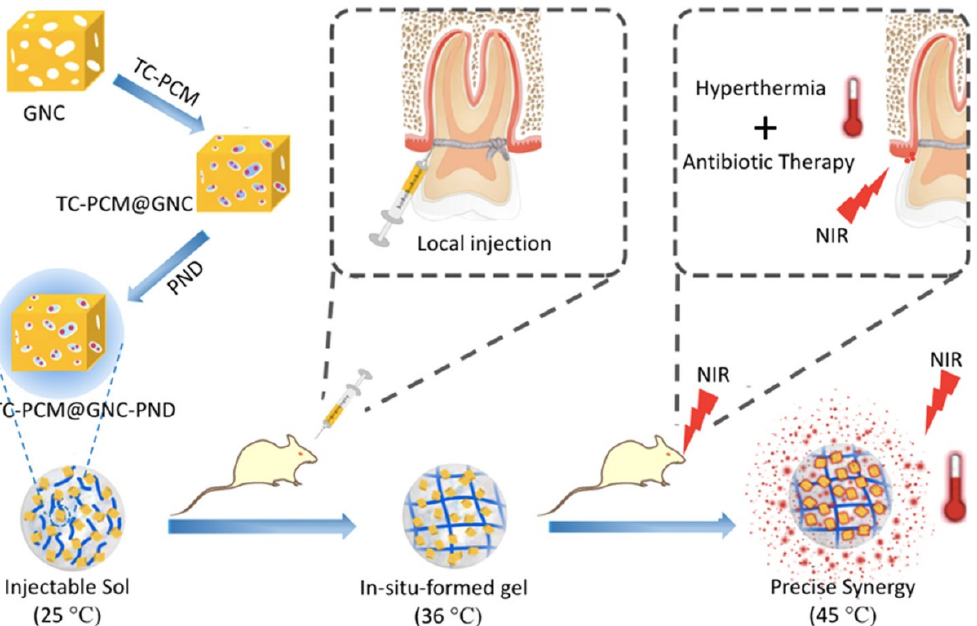
Figure 5. Schematic Illustration of TC-PCM@GNC-PND as a Combined Platform for Hyperthermia and Antibiotics with an Obvious Synergistic Antibacterial Effect. Reprinted with permission from Ref. [61] Copyright 2020 American Chemical Society.